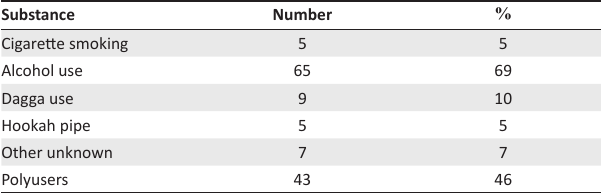
TABLE 2: Types of substances used ( n = 94).